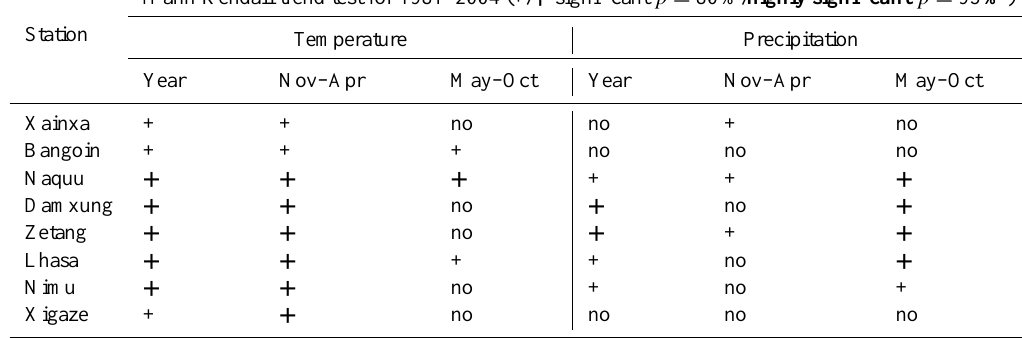
Table 4. Mann-Kendall trend test results for temperature and precipitation measurements over 24yr-period